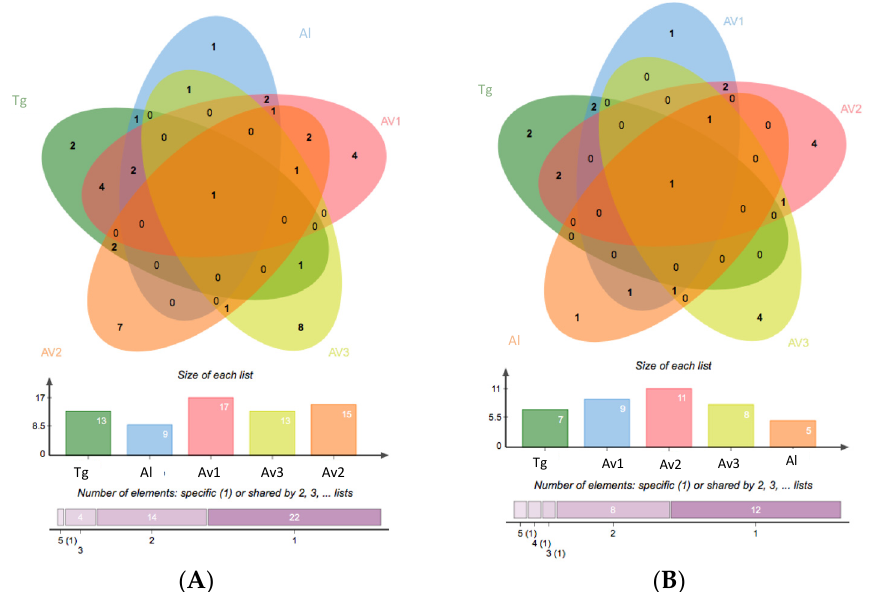
Figure A4. Venn diagram showing the abundance of isolates in the sampling sites represented by genera ( A ) and OTU ( B ).